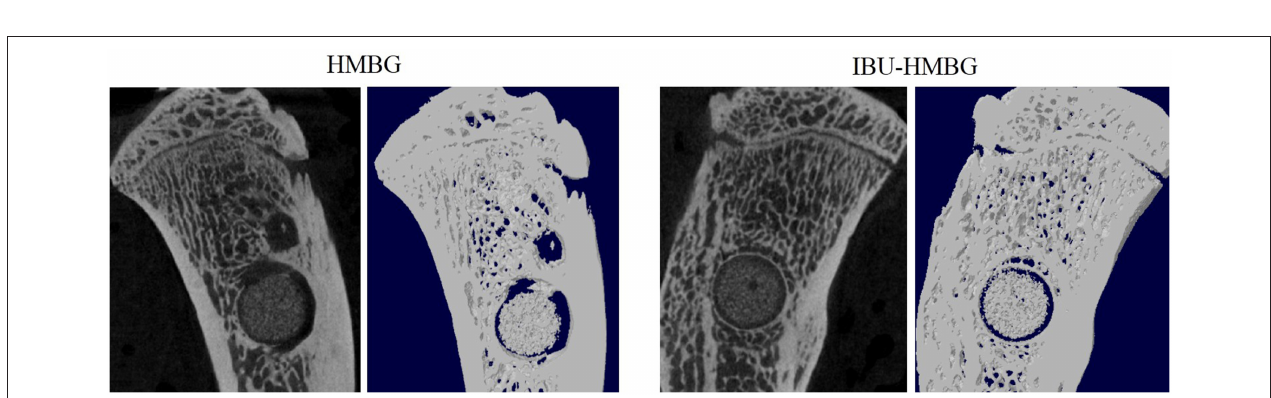
FIGURE 9 | HandE and Masson’s trichrome staining of HMBG and IBU-HMBG samples after 4 weeks. NB, new bone tissue; yellow circle, inflammation tissue.